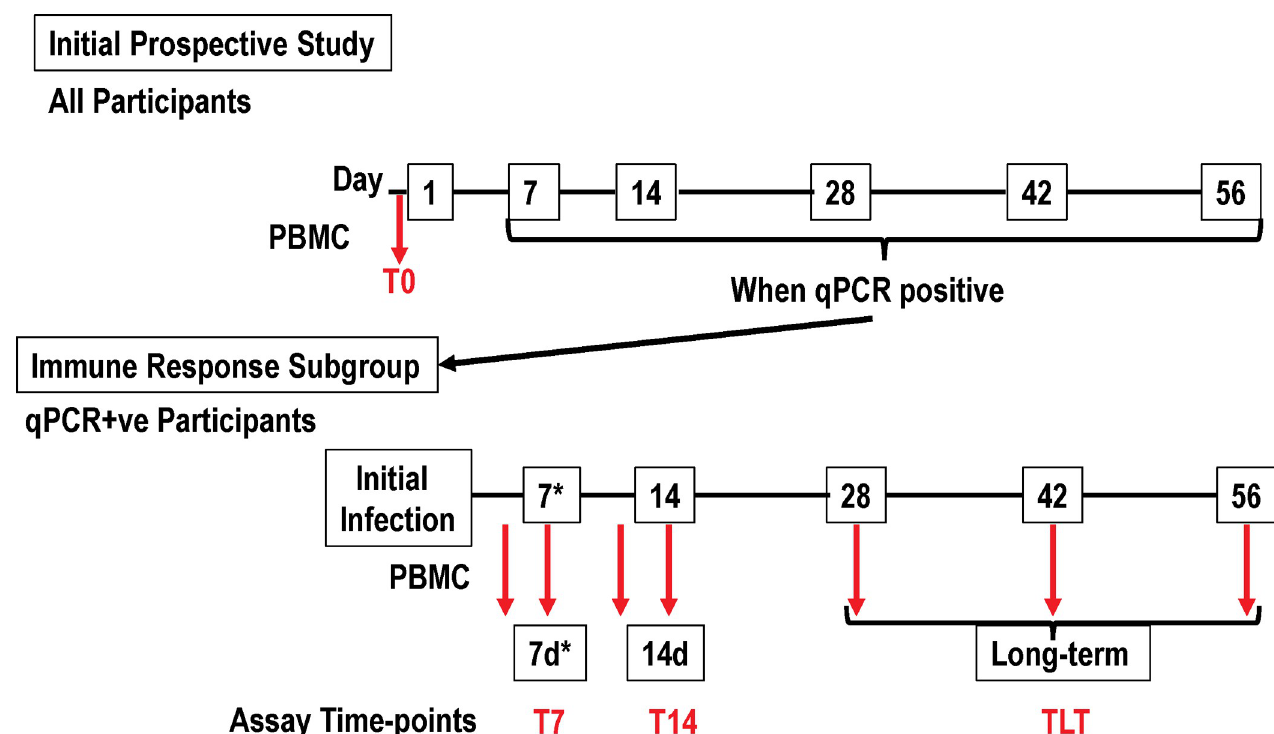
Fig 1. Participant flow: Times of FluoroSpot assays relative to the first positive PCR test. Participants were enrolled in the initial prospective study and tested by qPCR biweekly initially and then bimonthly. When qPCR positive, the participant was transferred to the immune response subgroup within 48–96 hours (7d � ) and tested by qPCR biweekly and bimonthly thereafter. PBMCs were isolated (red arrows) prior to the initial qPCR (at enrollment, T0), and once positive at ¾ days 7 days (grouped into T7), 10/11 days (grouped into T14), and greater than 28 days (time long-term (grouped into TLT) post qPCR positivity for